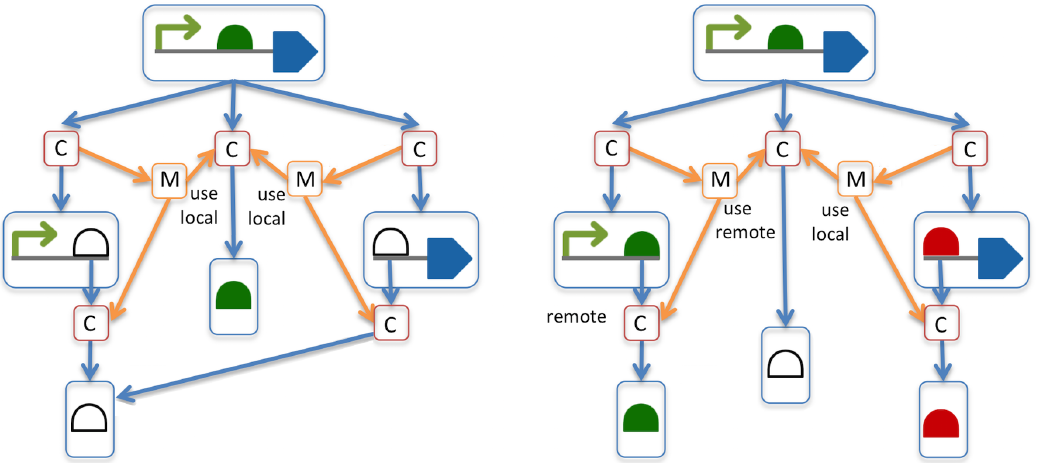
Figure 10: Linking Component objects using MapsTo entities. Boxes with diagrams represent ComponentDefinition objects, boxes with the C label represent Component objects, and boxes with the M label represent MapsTo objects.